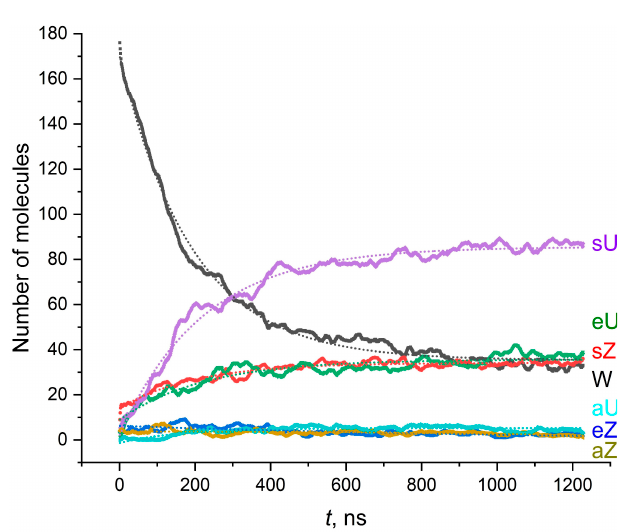
Figure 5. Changes in conformational composition in the bilayer AMA-W membrane during 1200 ns NPT MD ( T = 300 K). Dotted lines are the fitted exponential regression models.